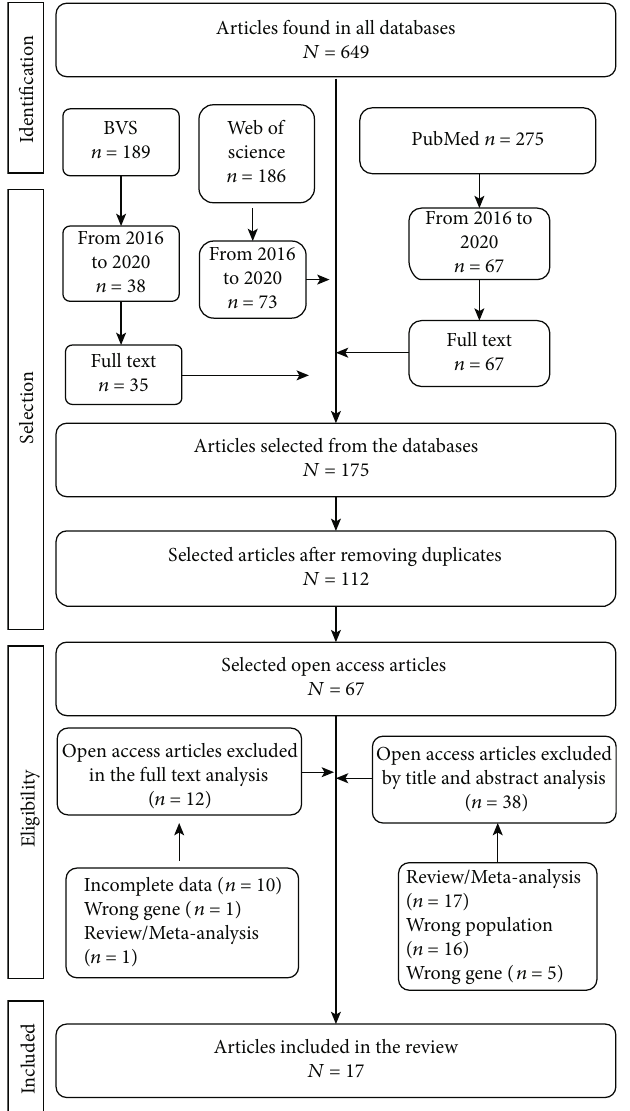
Figure 1: Performed bibliographic research fl owchart.